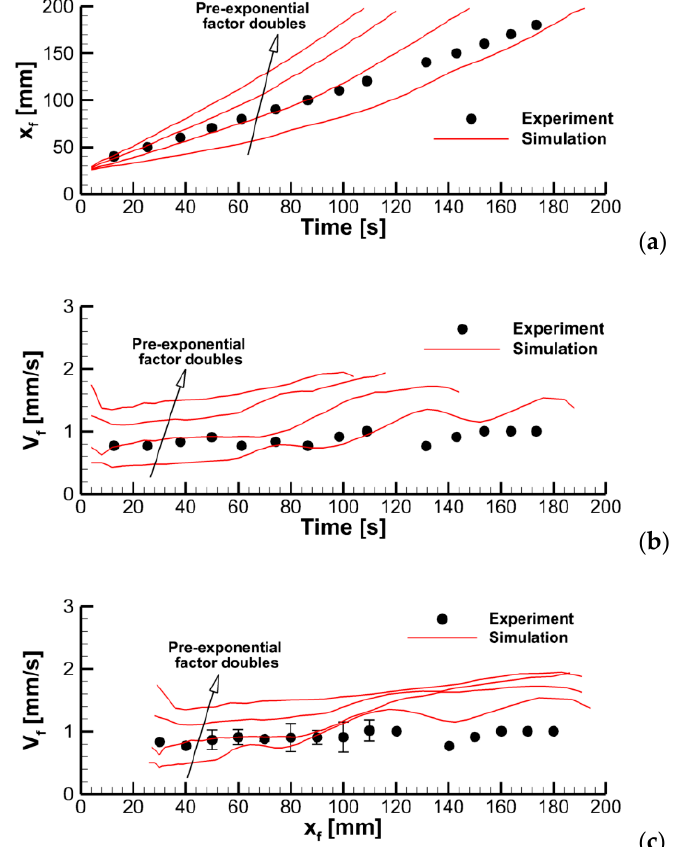
Figure 12. Dynamics of flame propagation in the axial plane: ( a )—the pyrolysis front coordinate vs. time; ( b )—front propagation velocity vs. time; ( c )—flame propagation velocity vs. pyrolysis front coordinate. Solid lines—simulations with the pre-exponential factors of volatile oxidation reaction rate equal to 0.28 ‧ 10 14 , 0.56 ‧ 10 14 , 1.125 ‧ 10 14 , and 2.25 ‧ 10 14 (m, mol, s).